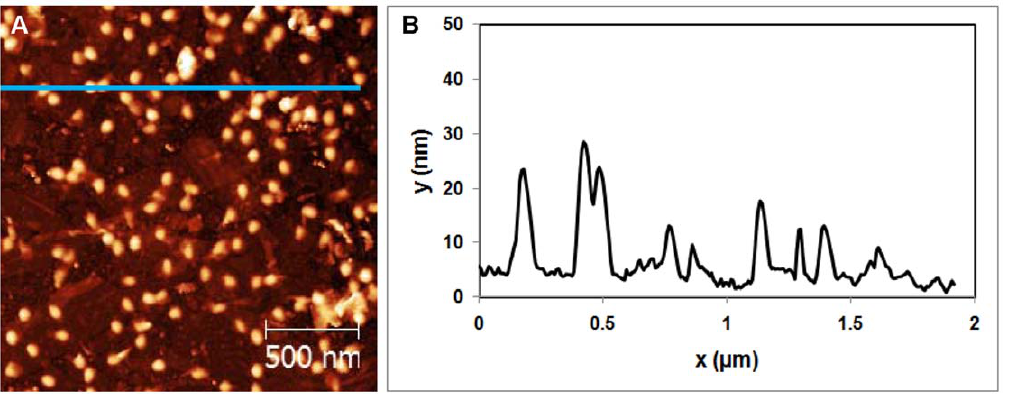
Figure 7. Topography of Mica/GaAl 12 /Nanosheets/GaAl 12 /APTES/Phage l /UV sample. (A) AFM image of virus solution adhered on SNT coated mica with GaAl 12 layer on top after the 15 min UV exposure. (B) Cross sectional image along the blue line shown in